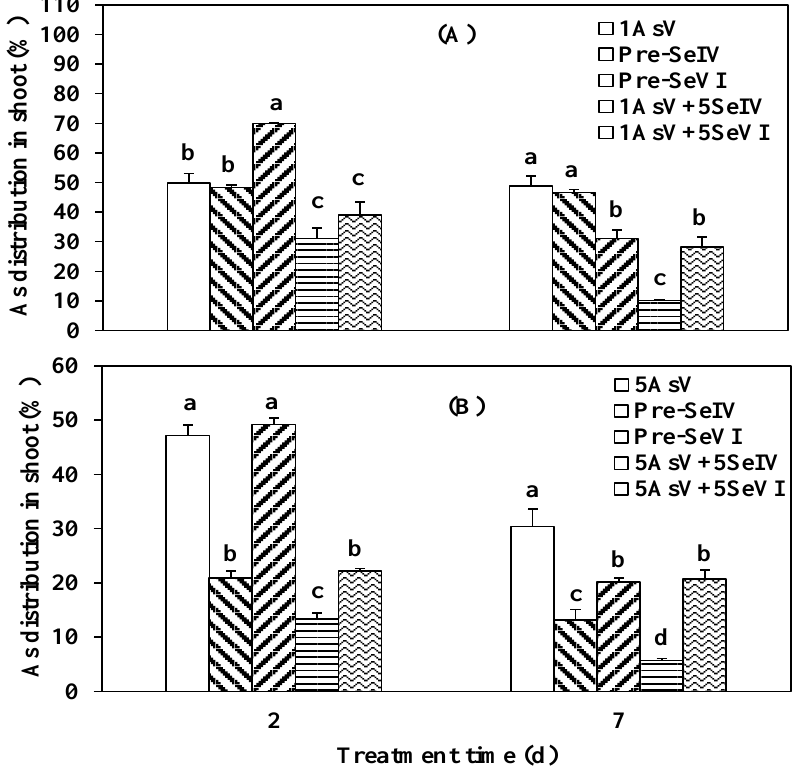
Figure 5. E ff ect of Se pretreatments and co-application on As translocation in the shoot of rice seedlings treated with low ( A ) or high ( B ) AsV concentrations. Data are mean value ± SE (n = 3). The letters indicate a significant di ff erence ( p < 0.05) among treatments.